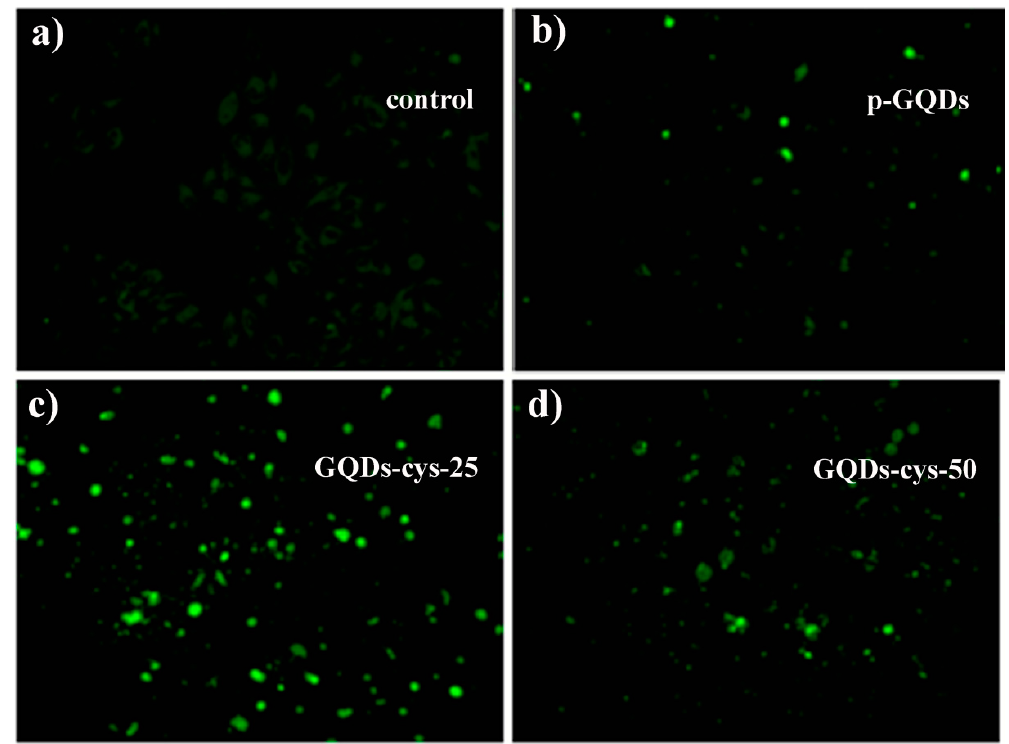
Figure 8. Fluorescence microscope images of HeLa cells without GQDs ( a ), cells treated with p-GQDs ( b ), with GQD-cys-25 ( c ), and GQD-cys-50 ( d ). HeLa cells were exposed to GQD samples at a concentration of 100 µg mL − 1 and incubated for 24 h.